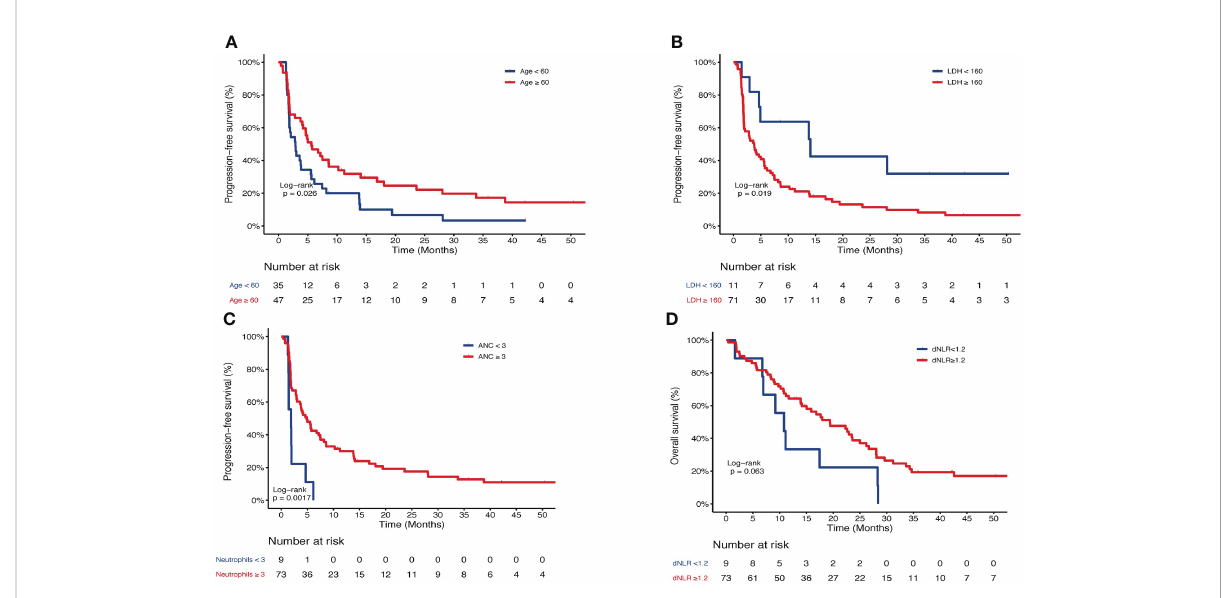
FIGURE 3 Kaplan-Meier curve of PFS or OS of patients in the nivolumab group. PFS of patients strati fi ed by (A) age, (B) LDH, and (C) ANC. (D) OS of patients strati fi ed by dNLR. PFS, progression-free survival; OS, overall survival; LDH, lactate dehydrogenase; ANC, absolute neutrophil count.